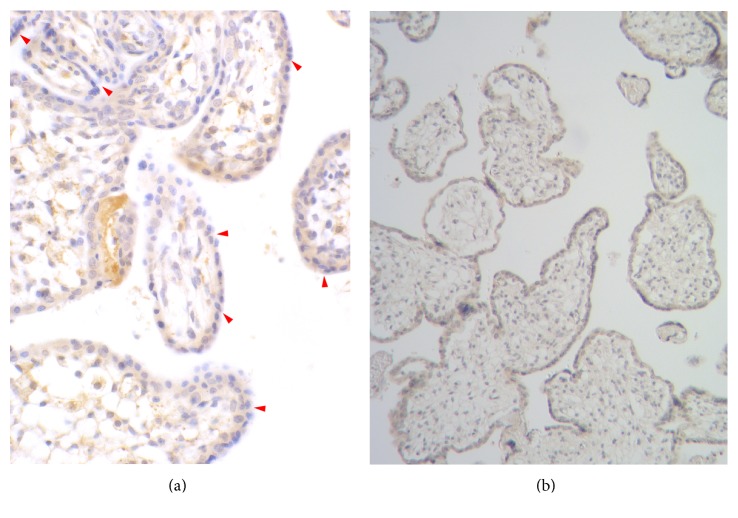
Immunohistochemical visualization of the receptor CX3CR1 in perfused placental tissue at 200x magnification (a) with the negative control ((b); mag. 100x). The image captured through optical microscope was digitally transformed for morphometric purposes. Immunostain-positive focal regions to a large extend correspond to the vascular endothelium (arrowheads). A single visual field observed with the naked eye looks substantially uniformly within each studied group. For that reason, only one immunostaining is presented for CX3CR1.